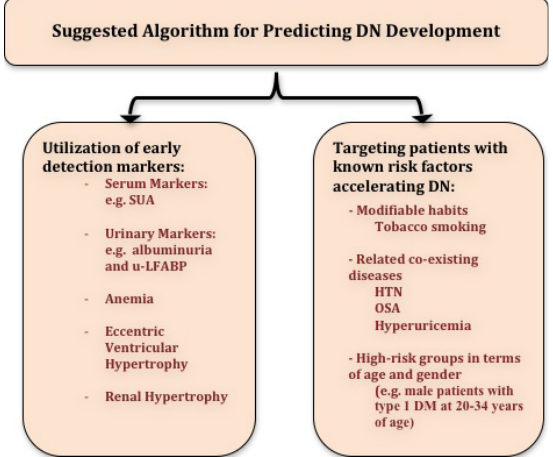
Figure 4. A suggested simplified algorithm utilizing various tools with the attempt of early predicting of DN. Utilizing two parallel approaches, early detection markers and screening high- risk individuals might constitute a promising methodology in prediction and prevention of DN